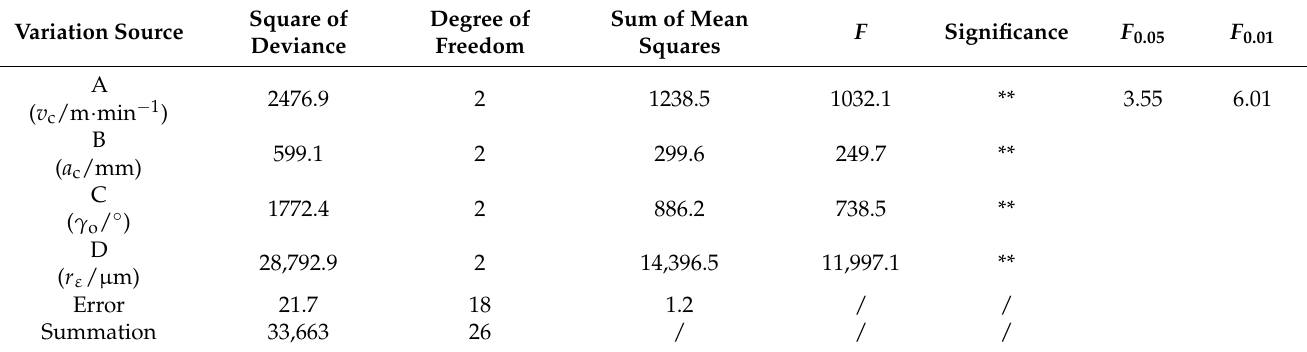
Table 8. Analysis of variance of cutting forces along the vertical